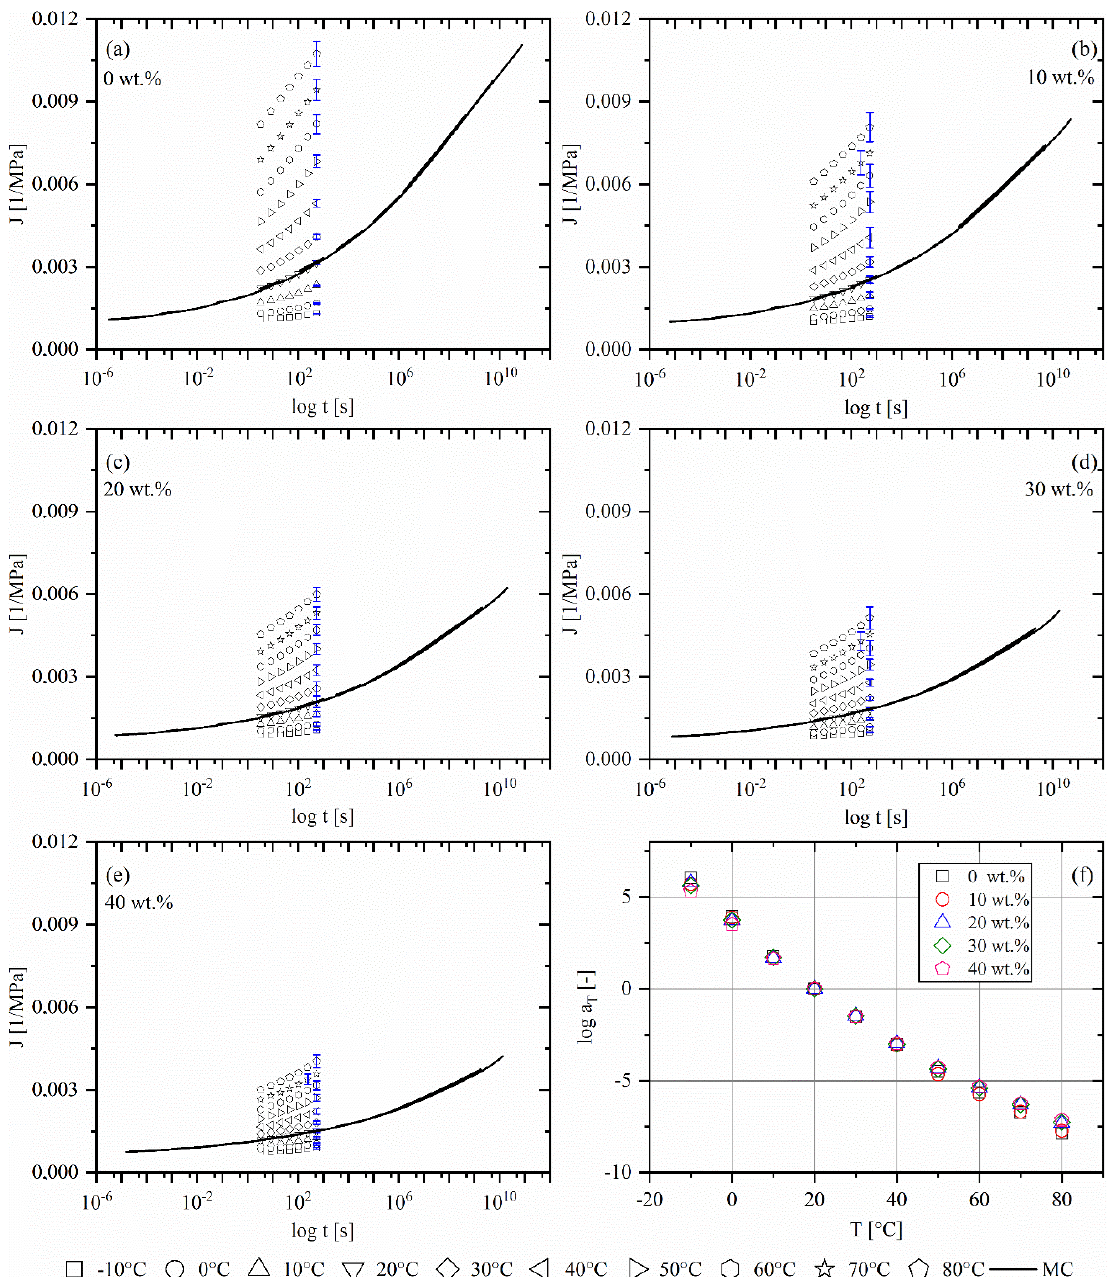
Figure A1. ( a – e ) Individual segments with corresponding mastercurves at T ref = 20 ◦ C for different wood fiber concentrations and ( f ) temperature shift factors. All diagrams show composites with an NPP matrix.